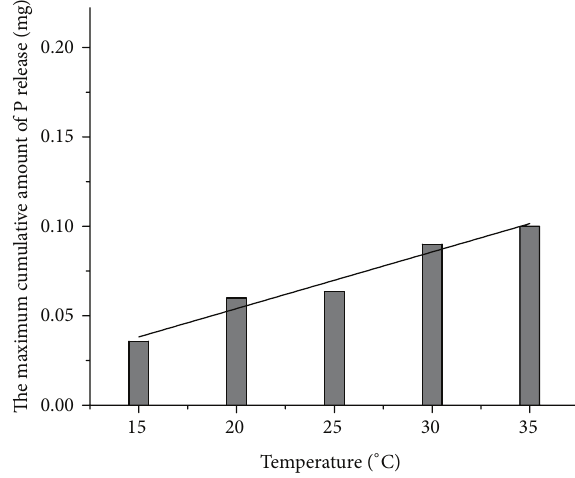
Figure 4: Maximum cumulative amount of P release as a function of temperature.